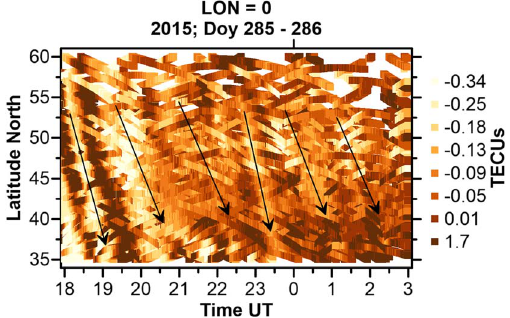
Fig. 6. Time – latitude-plot of TEC perturbations for the 12 – 13 October 2015 18:00 – 03:00 UT at 0 (cid:3) E. The arrows indicate the valleys of the disturbance